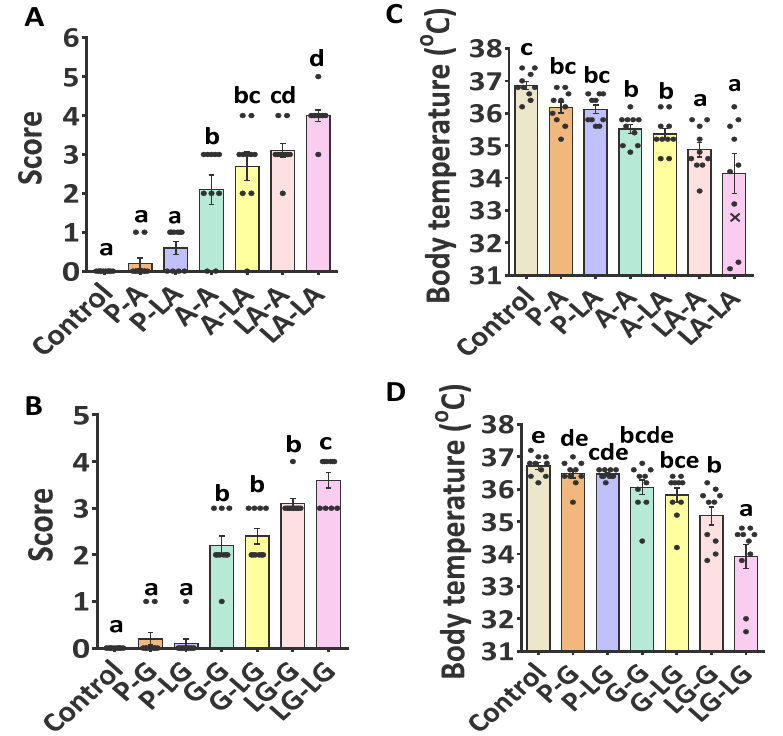
Figure 3. Score of hypersensitivity symptoms ( A , B ) and body temperature ( C , D ) in BLA and BLG group were followed by i.g. challenges 40 min apart. The symptoms of hypersensitivity were scored on a scale from 0 (no symptoms) to 5 (death), as described in Table S1. Each point represented data from an individual mouse, and values were expressed as means ± SEM ( n = 10). The results are representative of two independent experiments. Statistical significance was determined by one-way ANOVA, followed by Tukey’s multiple comparisons test. The groups without the same letter in the histogram bar have statistical differences ( p <